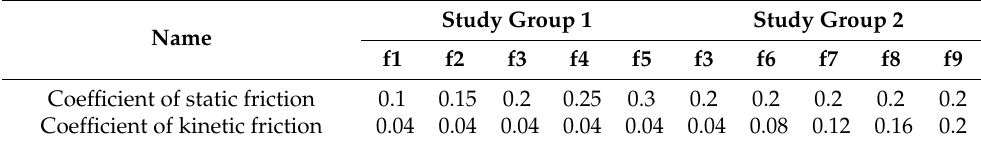
Table 3. Guide rod and guide hole friction coefficient configuration table.